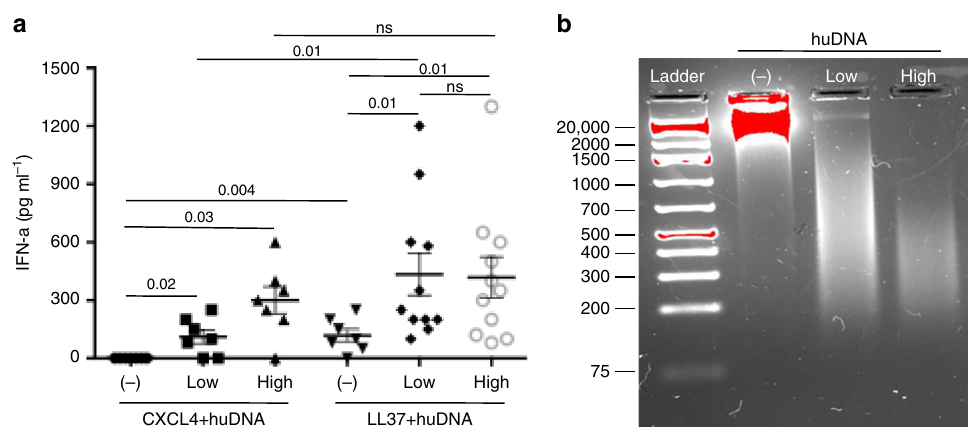
Fig. 4 Stimulation of pDCs by CXCL4 – DNA complexes is sensitive to the degree of DNA fragmentation. a PDCs were stimulated with huDNA unfragmented ( − ) or huDNA moderately (low) and highly (high) fragmented by sonication (see Methods) in complex with CXCL4 (1 µ M) or LL37 (10 µ M). IFN- α production was quanti fi ed by ELISA after 24 h. Horizontal bars are the mean, vertical bars are s.e.m., P -values from Student ’ s t test for paired samples (two-tailed). b Two percent agarose gel shows unfragmented ( − ) and the degree of fragmentation (low and high) of the huDNA preparation used for the functional assays depicted in